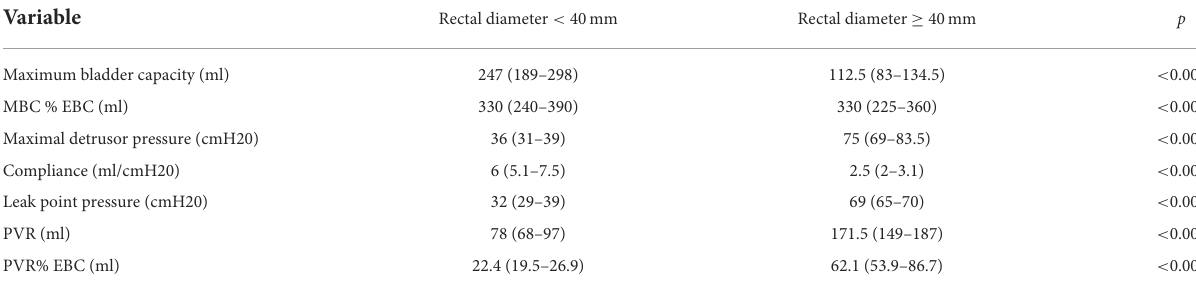
TABLE 2 Urodynamic findings of study population by transversal rectal